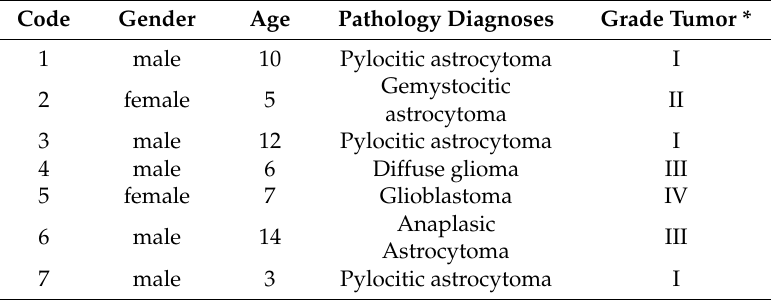
Table 1. Characteristics of the pediatric glioma samples.